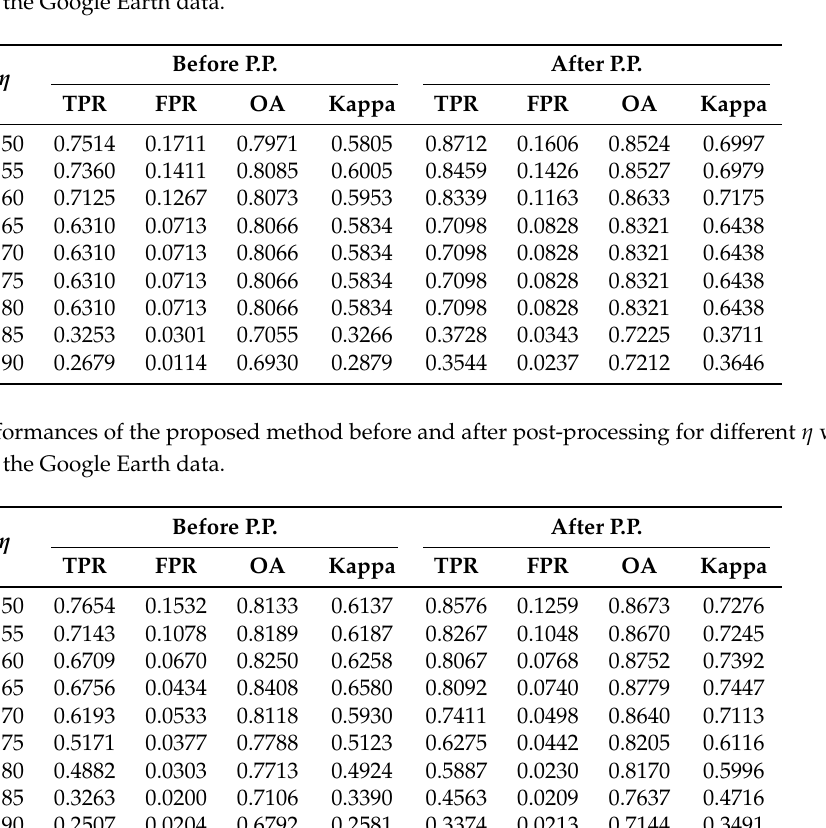
Table 1. Performances of the proposed method before and after post-processing for different η when n = 15 using the Google Earth data.